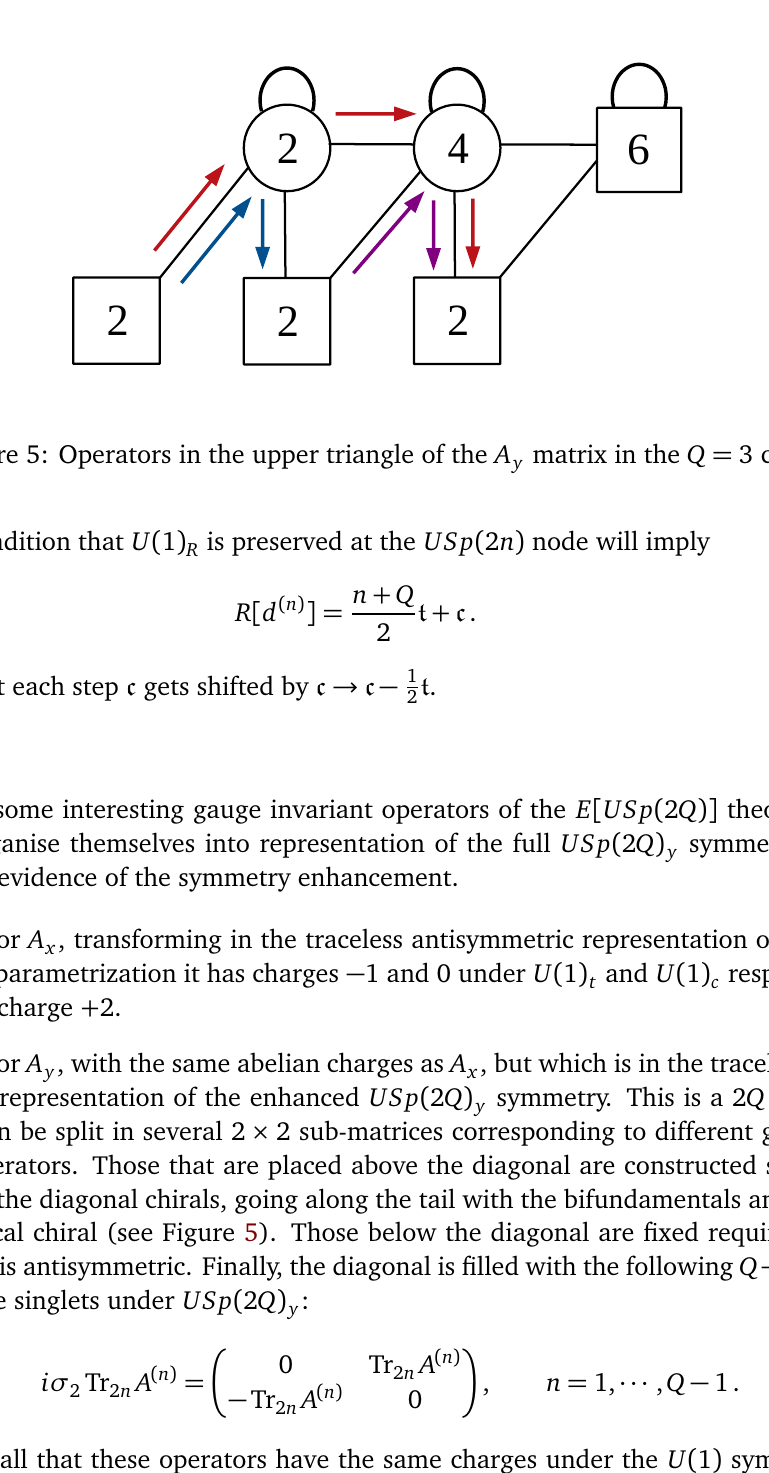
Figure 5: Operators in the upper triangle of the A